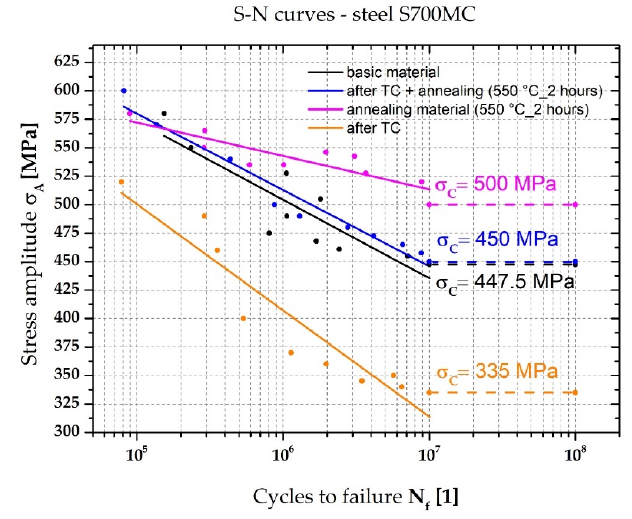
Figure 13. Comparison of all measured S–N curves, base material (black curve), annealed material at 550 °C for 2 h (pink curve), after TC (orange curve), after TC + HT 550 °C for 2 h (blue curve).